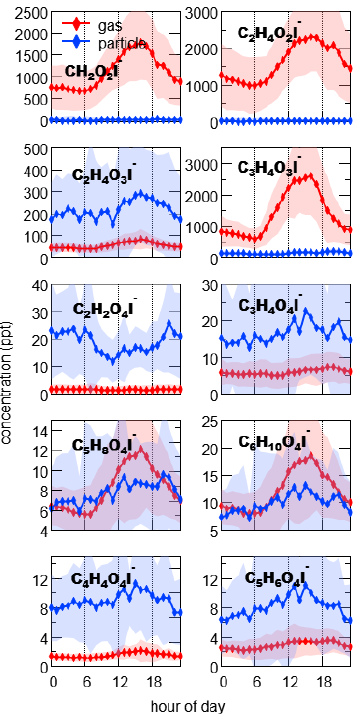
Figure 6. Diurnal variations of organic acids in the gas phase (red) and particle phase (blue). The shaded area indicates 1 standard de- viation.